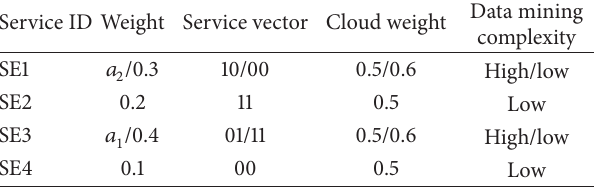
Table 2: Service opportunistic driven.